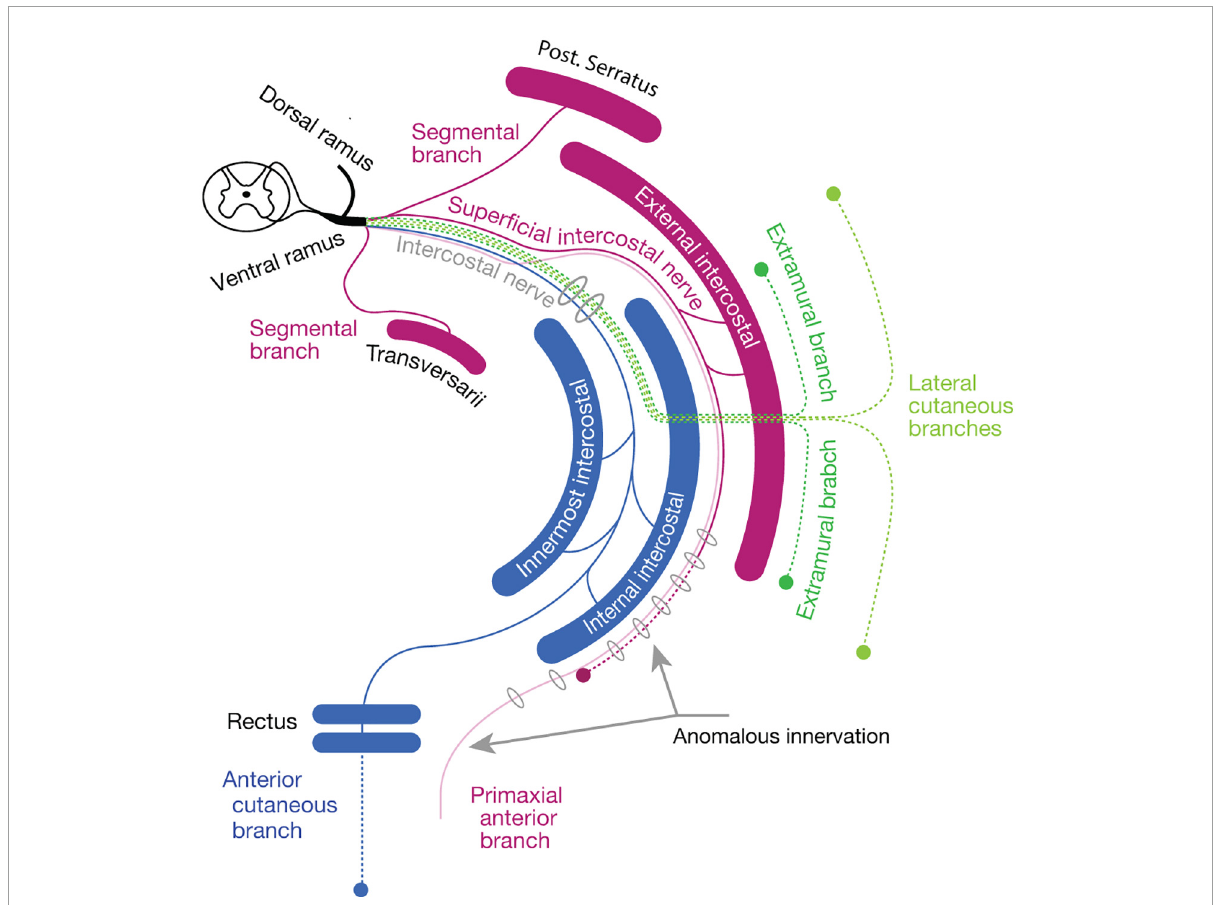
FIGURE8 The reasoning for the genesis of an anomalous dual innervation to the rectus muscle. The color code is as same as Figure 7 . The anomalous branch, as a vestigial superficial anterior branch (primaxial anterior branch, opaque purple), runs together with the superficial intercostal nerve, creating an appearance of the extension of the superficial intercostal nerve to the rectus